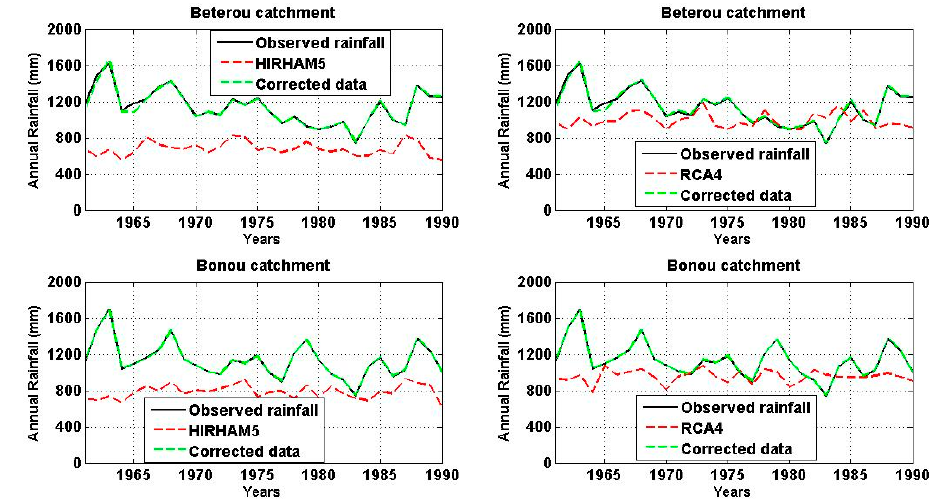
Figure 4. Observed annual, raw RCM and corrected bias rainfall over the period 1961–1990 for Bétérou ( top ): HIRHAM5 rainfall ( left ), RCA4 rainfall ( right ) and Bonou ( bottom ): HIRHAM5 rainfall ( left ), RCA4 rainfall ( right ) catchments of the Ouémé River.